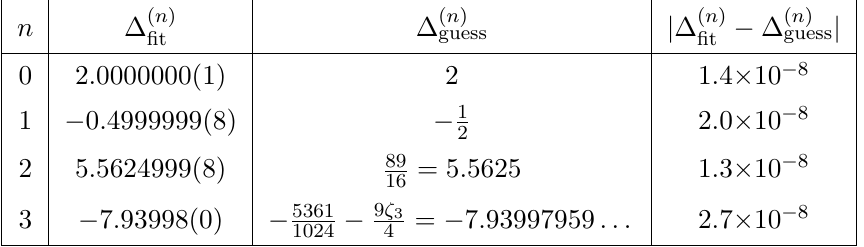
Table 5 . Strong coupling coe(cid:14)cients for the non-symmetric state with L = 4 ; S = 1, K 4 6 = K (cid:22)4